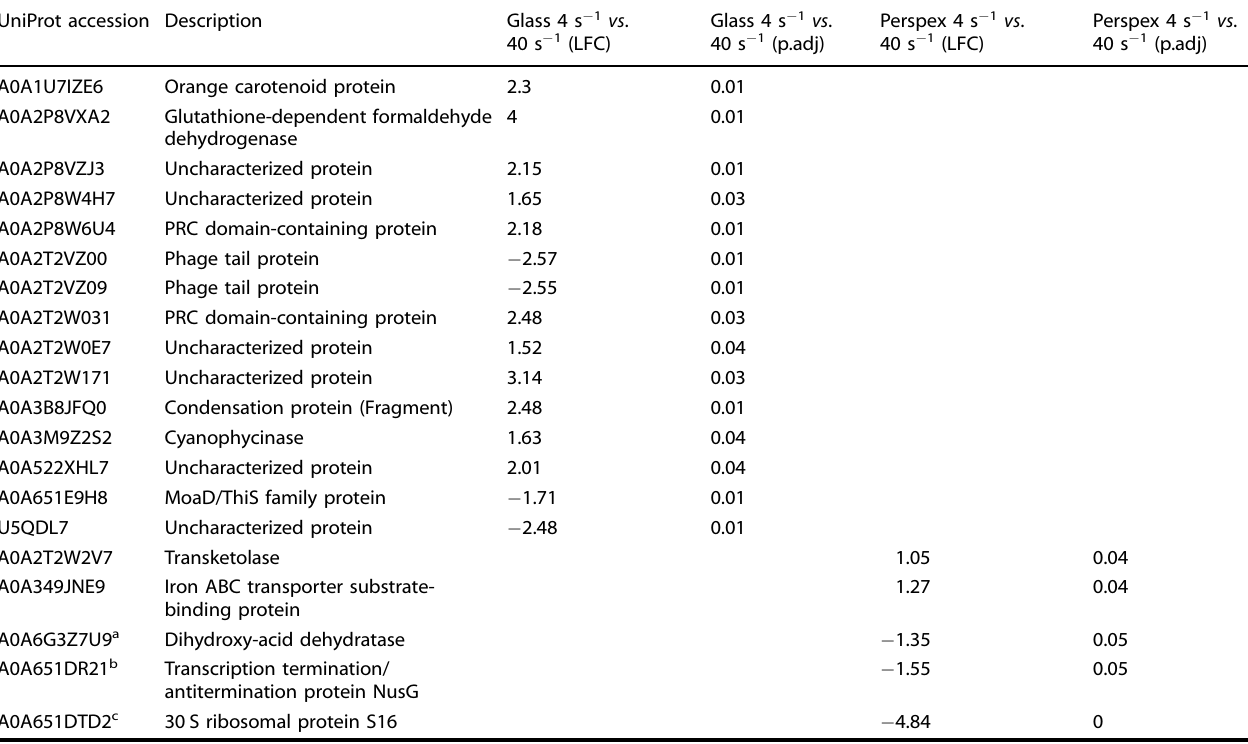
Table 1. List of the DEPs found between comparisons of the same surface studied at different hydrodynamics conditions. UniProt accession